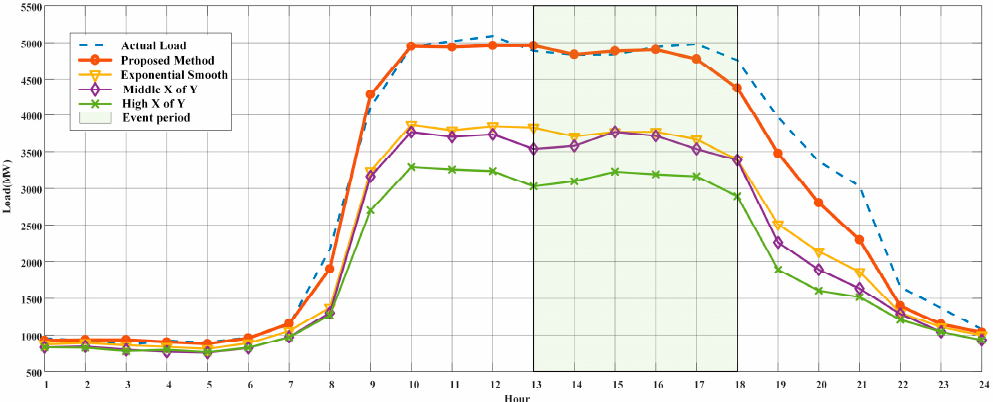
Figure 12. CBL calculation: the comparison among proposed method and traditional methods.